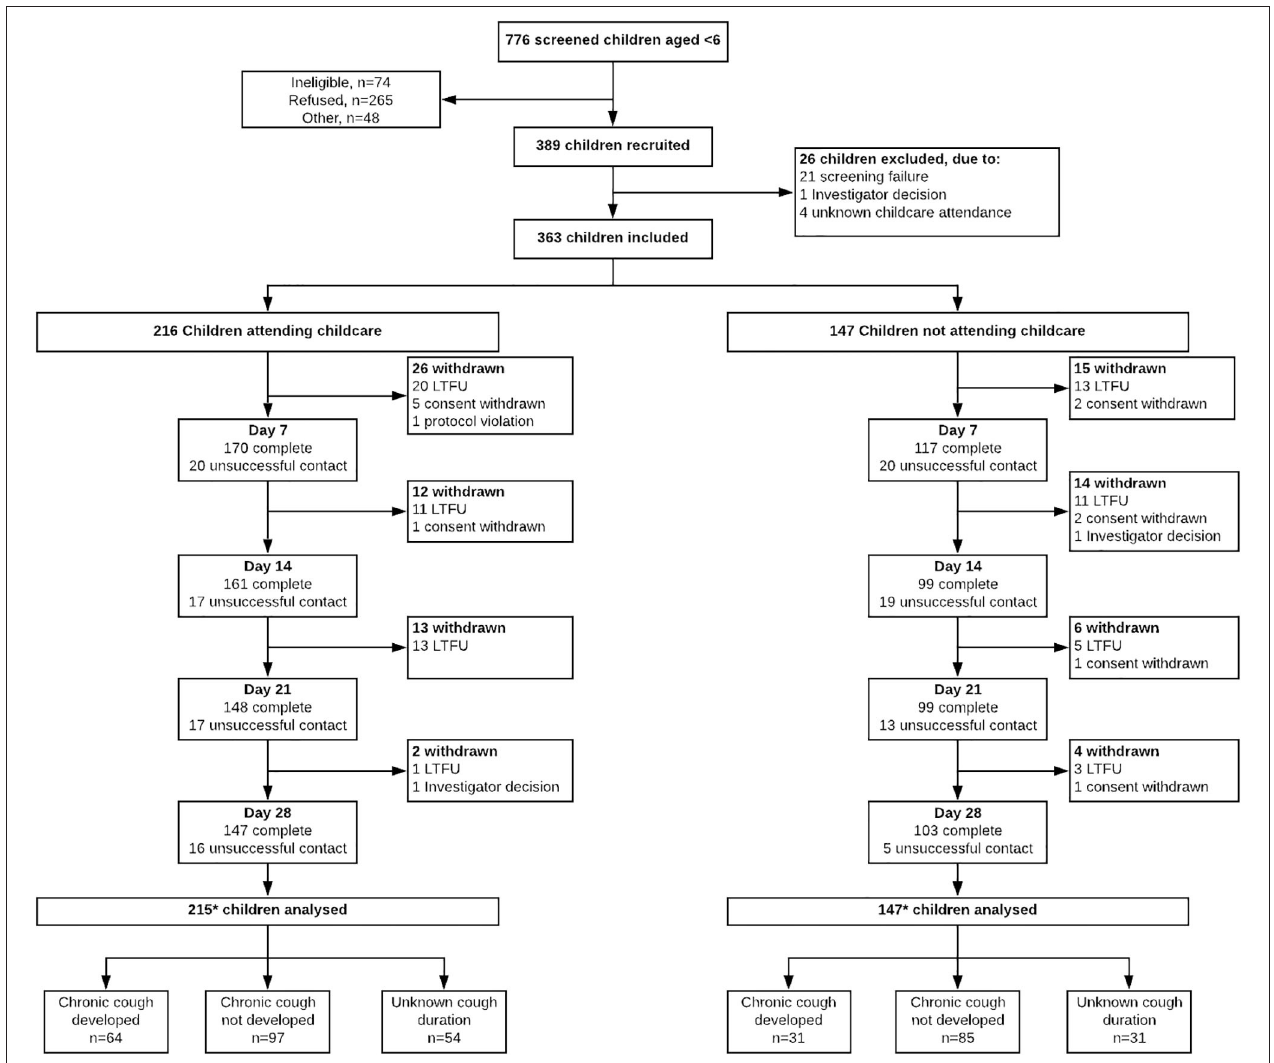
FIGURE 1 | Flow diagram of screening, enrolment and follow-up of children aged < 6-years presenting with cough as a symptom to three primary health care services and three hospital emergency